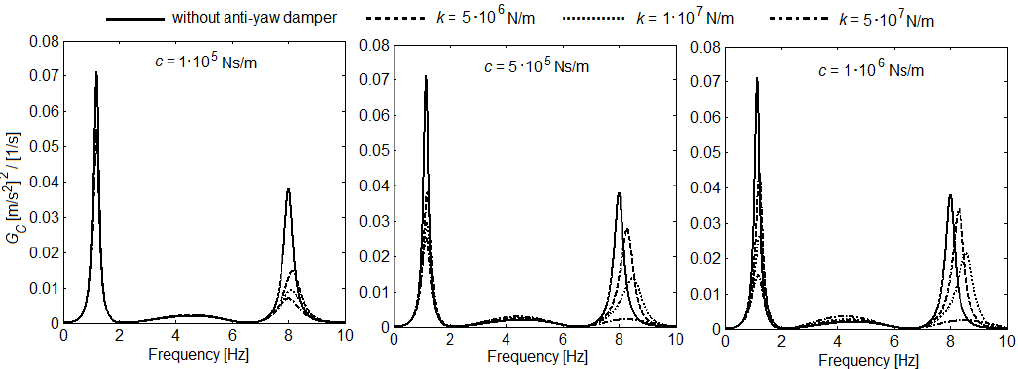
Figure 3. Influence of the damping and the anti-yaw damper stiffness upon the power spectral density